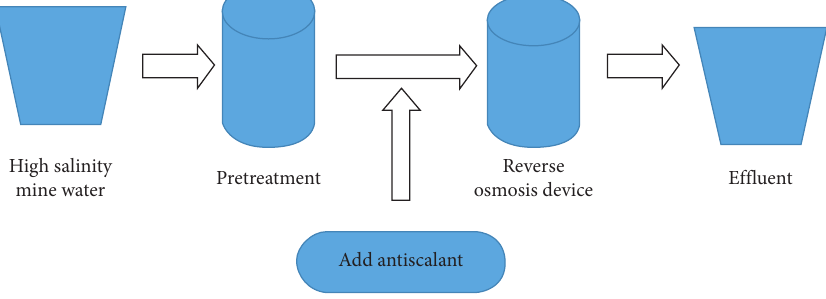
Figure 4: Reverse osmosis process.